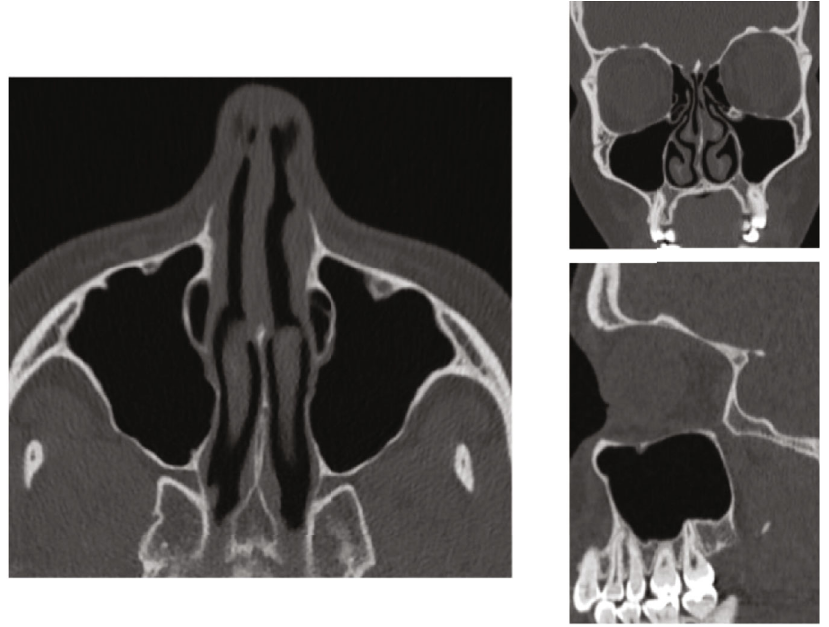
Figure 1: CT scan of the maxillary sinuses showing the anatomy of the sinuses and their relationship to the teeth.